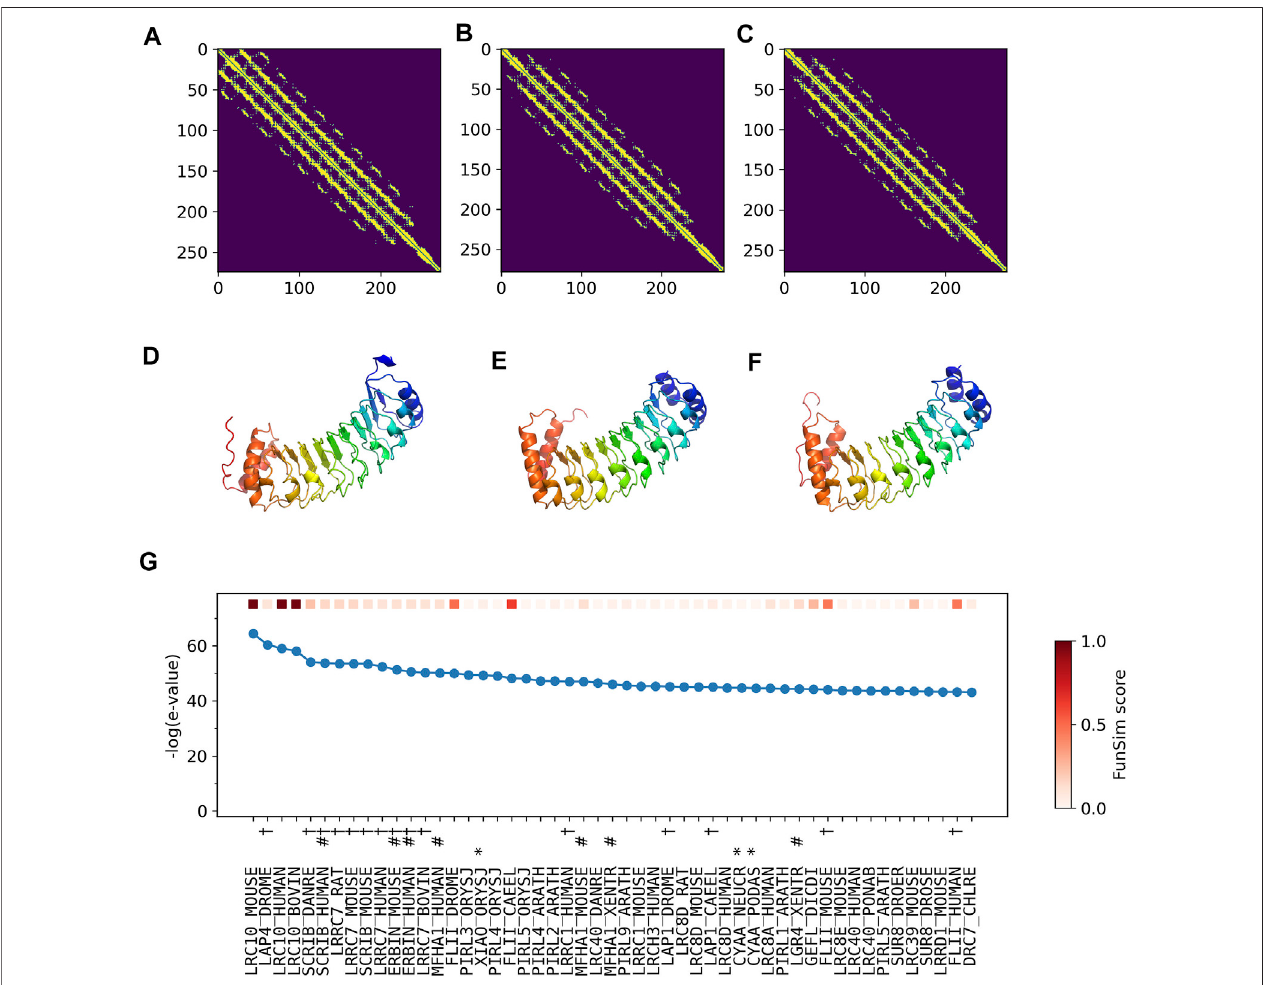
FIGURE6| IllustrationofGOtermpredictionsbyContactPFPforLeucine-richrepeat-containingprotein10frommouse(LRC10_MOUSE,Q8K3W2).Residuepair contact prediction of (A) The query, LRC10_MOUSE; (B) Leucine-rich repeat-containing protein from bovine, LRC10_BOVIN (Q24K06), and (C) Leucine-rich repeat- containing protein from human LRC10_HUMAN (Q5BKY1). The following three panels, (D – F) , are the corresponding predicted structures of these three proteins, respectively. The color shows the orientation of the proteins from the N-terminus to the C-terminus from blue to red. There are no experimentally determined structures for these proteins. (G) The top 50 hits for the query by PSI-BLAST against Swiss-Prot. Funsim scores compared with the query protein are shown in the top row in a color scale. The leftmost column is the query itself. The protein names associated with the “ incorrect GO terms ” listed in Table 4 are marked with the corresponding symbols, *, “ ATP binding ” (GO:0005524); #, “ defense response ” (GO: 0006952); and † “ cell junction ”